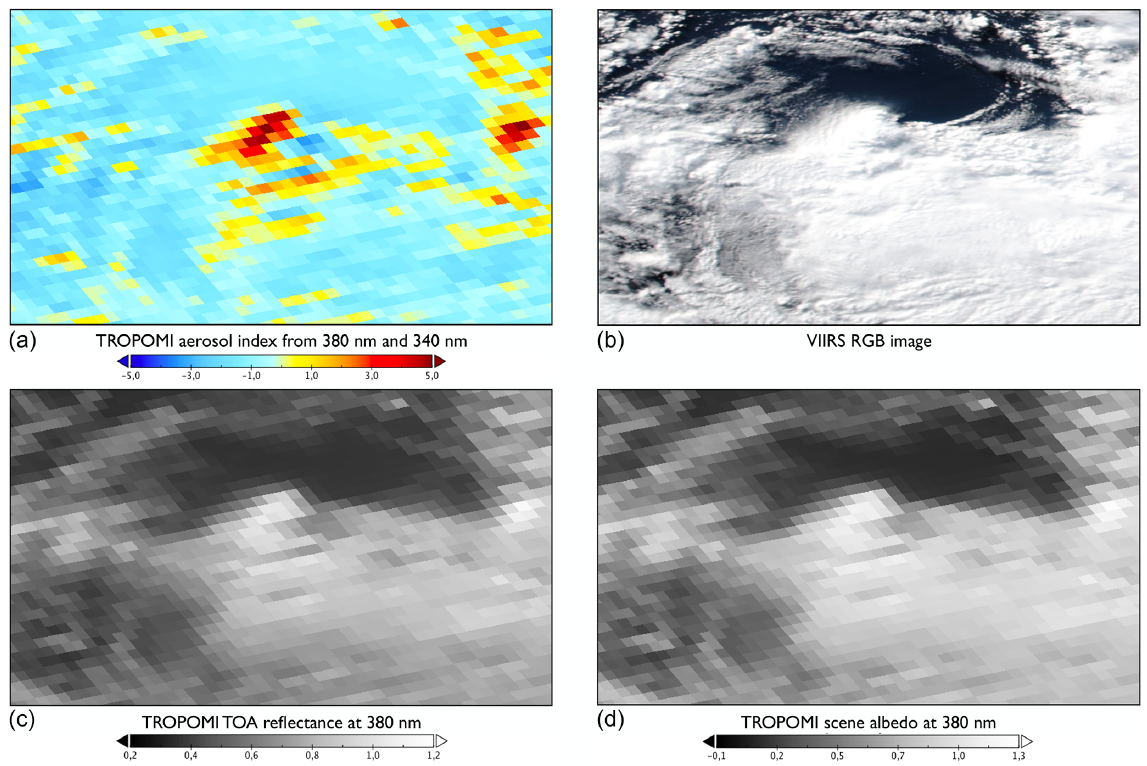
Figure 2. TROPOMI AAI (a) , VIIRS RGB color image (b) , TROPOMI top-of-atmosphere reflectance at 380nm (c) , and TROPOMI- calculated scene albedo 380nm (d) of a cloudy scene over the South Pacific Ocean (57.3 ◦ S, 120.4 ◦ W) on 30 August 2018 (orbit 4562). The size of the depicted area is approximately 245km × 230km. VIIRS image credit: